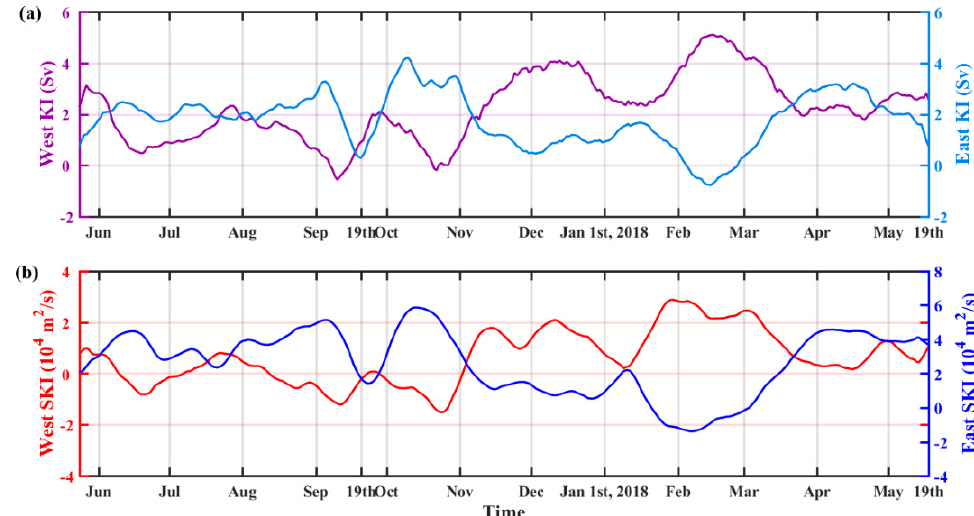
Figure 7. The KI across the western continental slope (D1–D2 in Figure 1) and across the eastern continental slope (D2–D3 in Figure 1). ( a ) The magnitude of the KI was derived from analysis data and calculated based on the vertical integral of the volume transport; ( b ) the magnitude of the SKI was derived from altimeter data and calculated based on the horizontal integral of the geostrophic velocity. A 15-d low-pass filter was applied to the primary data.